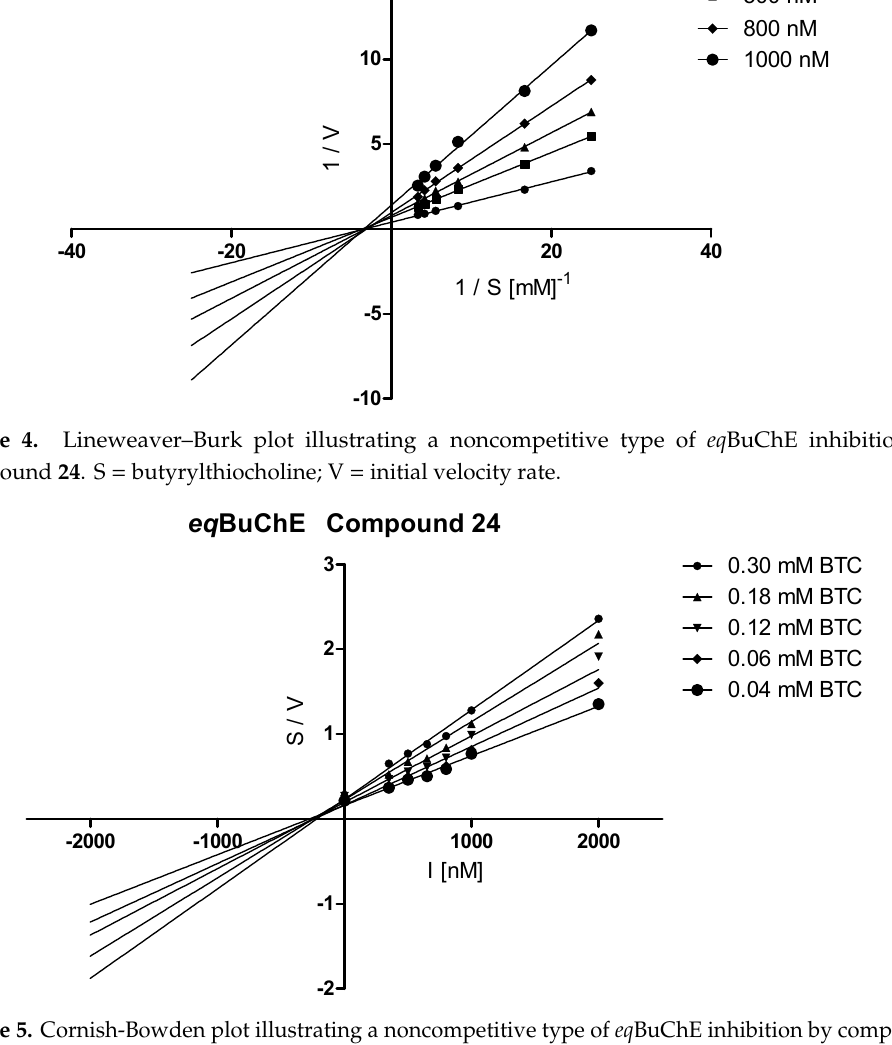
Figure 5. Cornish-Bowden plot illustrating a noncompetitive type of eq BuChE inhibition by compound 24 . S = butyrylthiocholine; V = initial velocity rate; I = inhibitor concentration.